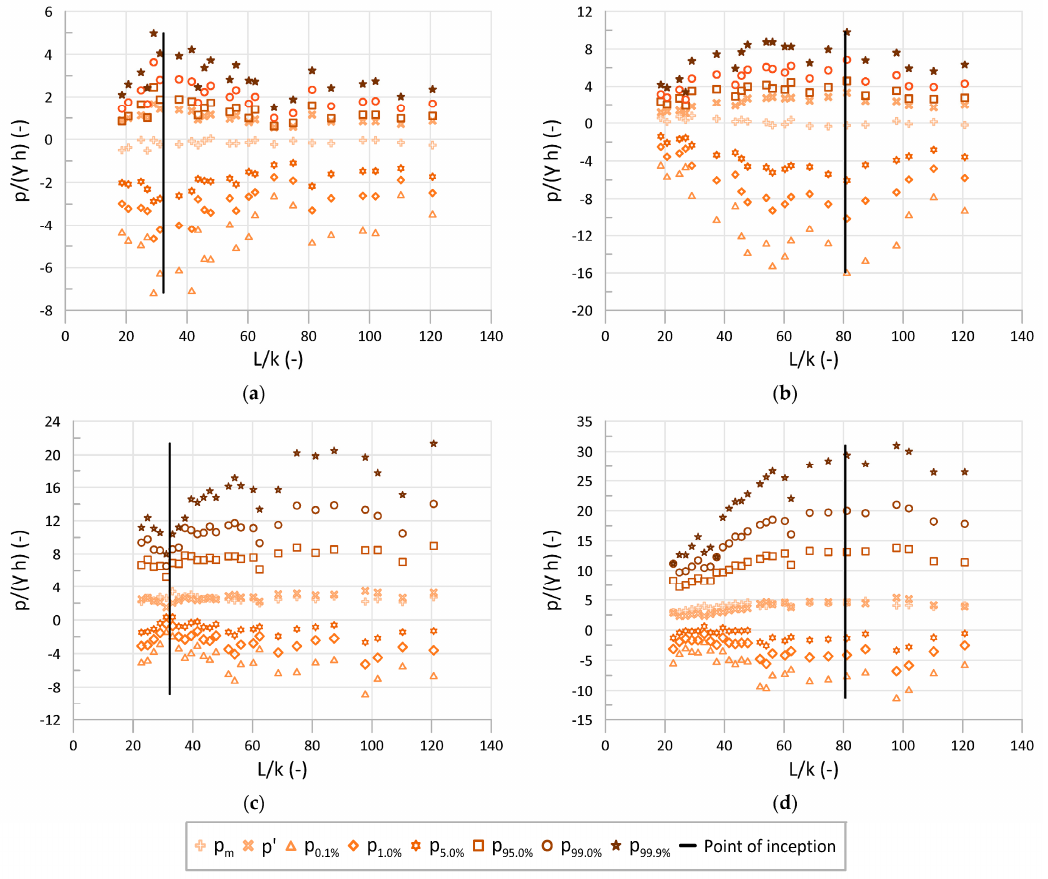
Figure 4. Streamwise development of the dimensionless mean, fluctuating, and extreme pressures at the LOH II stepped chute: ( a ) vertical face of the step, near the outer edge (z/h = 0.133), for d c /h = 2.20; ( b ) vertical face of the step, near the outer edge (z/h = 0.133), for d c /h = 4.90; ( c ) horizontal face of the step, near the outer edge (y/l = 0.178), for d c /h = 2.20; ( d ) horizontal face of the step, near the outer edge (y/l = 0.178), for d c /h =